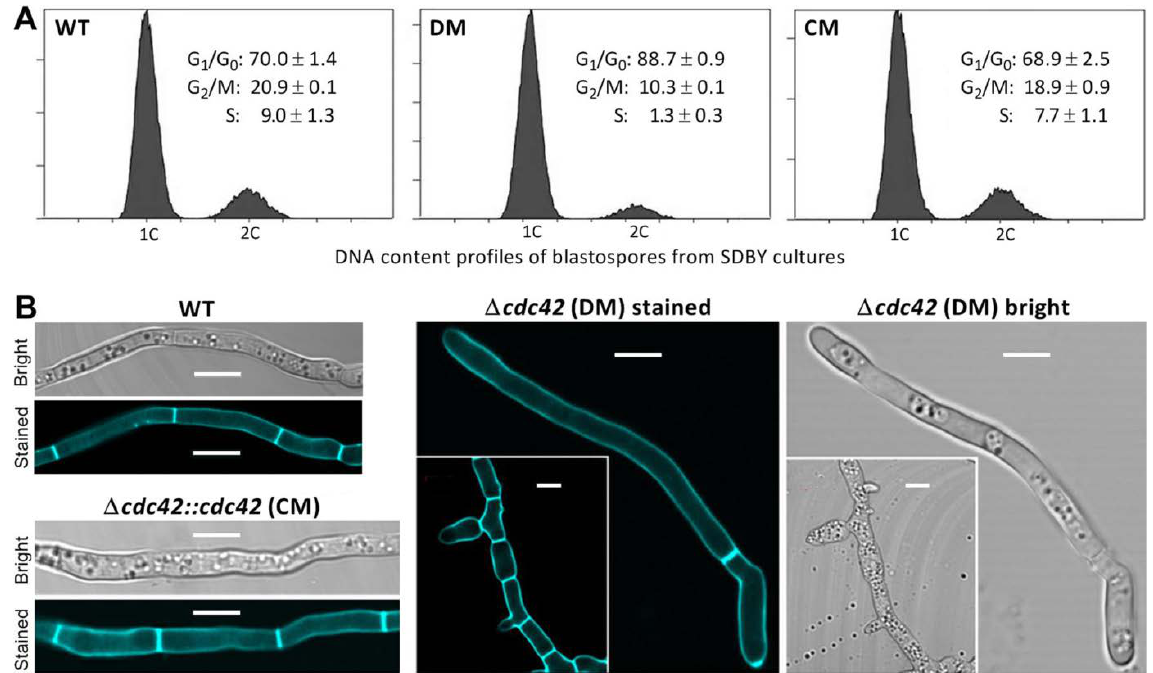
Figure 2. Impact of cdc42 deletion on the cell cycle of blastospores and the formation of hyphal septa in B. bassiana . ( A ) Cell-cycle patterns of unicellular blastospores stained with the DNA-specific dye propidium iodide after collection from the 3-day-old SDBY colonies incubated at optimal 25 ◦ C. Different cell-cycle phases are shown as standard deviations of the means from three samples per strain (2 × 10 4 stained spores per sample). ( B ) LSCM images (scales: 5 µ m) of hyphal septum patterns and morphology. The presented hyphae were stained with the cell-wall-specific dye calcofluor white after collection from the 3-day-old SDBY cultures. Note that two opposite types of abnormal septum patterns are present in the ∆ cdc42 mutant’s